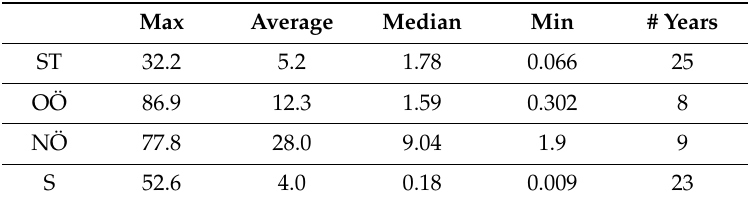
Table 3. Empirical statistics for the normalized damage data for the states with data. Maximal, minimal, average, and median yearly damage (in mio. € ) and the number of years with available data. Numbers in parenthesis are the 95% confidence intervals from the Monte Carlo Simulation.